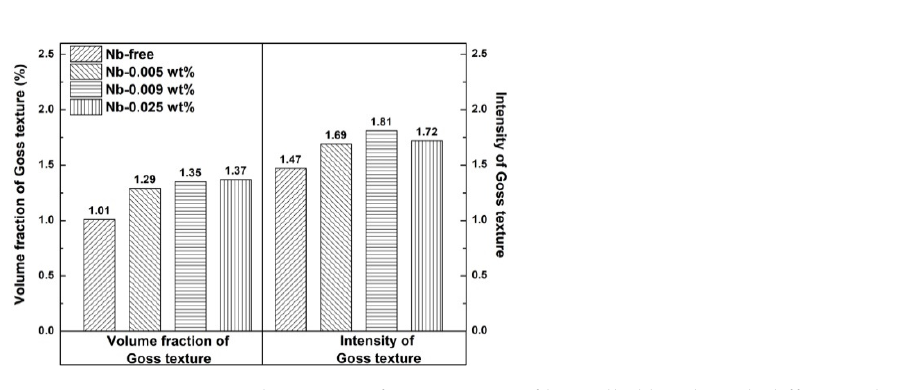
Figure 11. Proportion and intensity of Goss texture of hot-rolled bands with different Nb content.